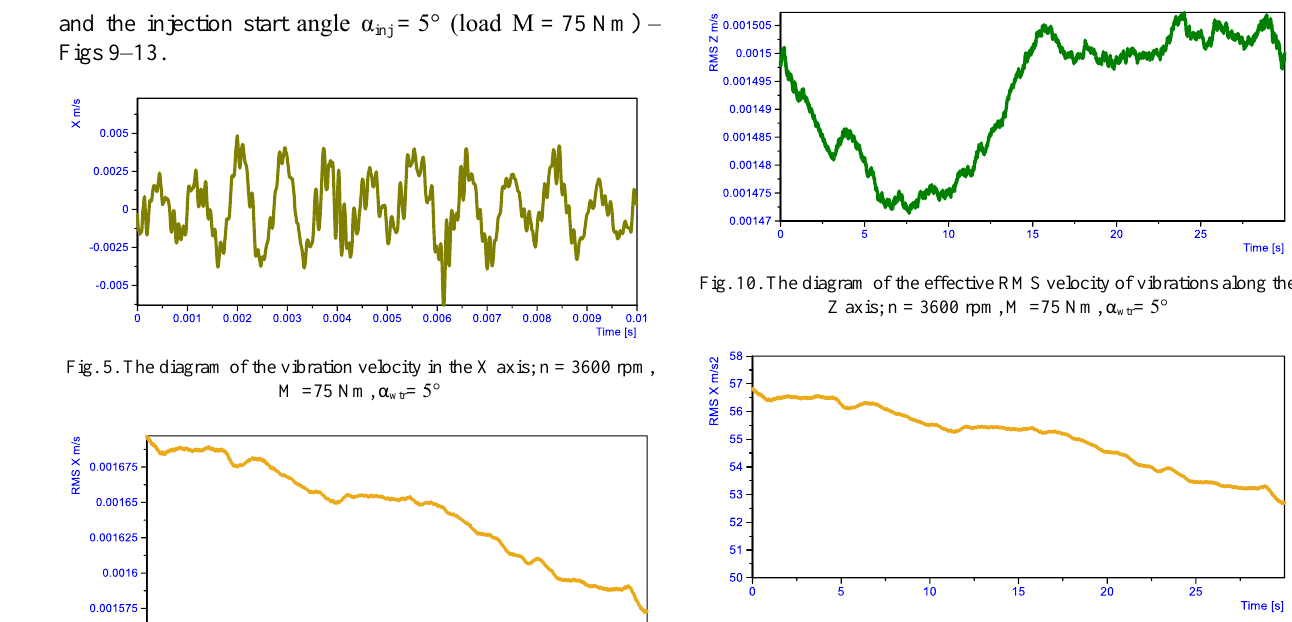
Fig. 11. The diagram of the effective RMS acceleration of vibrations along the X axis; n = 3600 rpm, M =75 Nm, α wtr = 5°